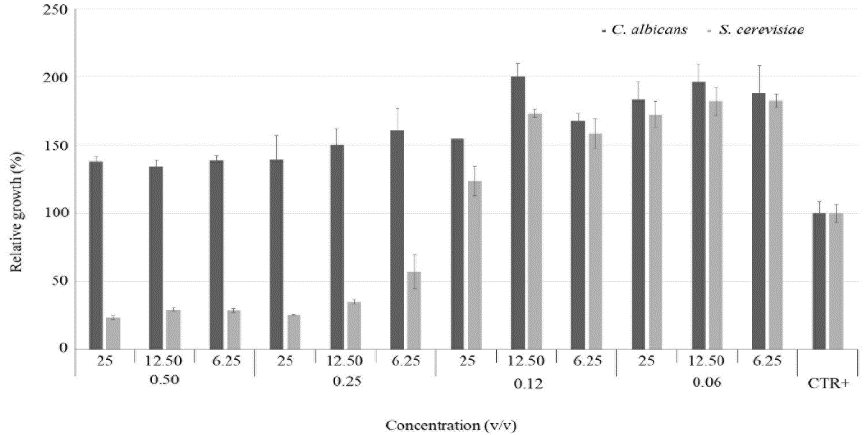
Figure 3. Relative growth of the clinical isolates of C. albicans (3.1) and S. cerevisiae (14.3) when cultured in presence of scalar dilutions of both the EO of C. aurantium var amara and the Hy of V. vinifera cv Italia. The values are relative to the positive control (CTR + ) and are expressed in percentage. The average of the two isolates’ positive controls is set at 100%.